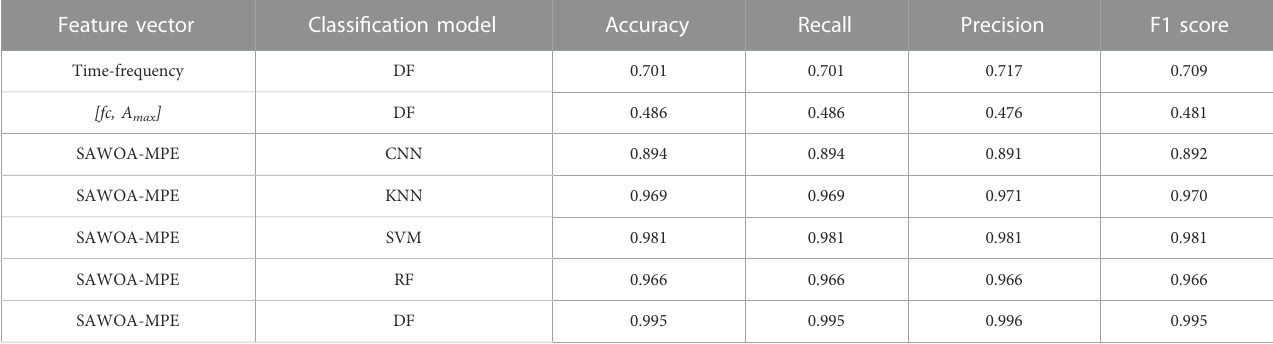
TABLE 7 Comparison results of different diagnosis